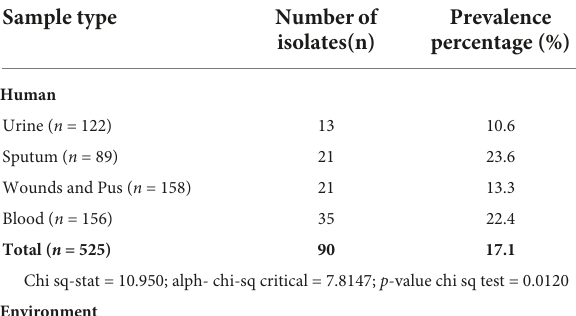
TABLE 1 Details of all the collected samples and percentage prevalence of K. pneumoniae from various sample